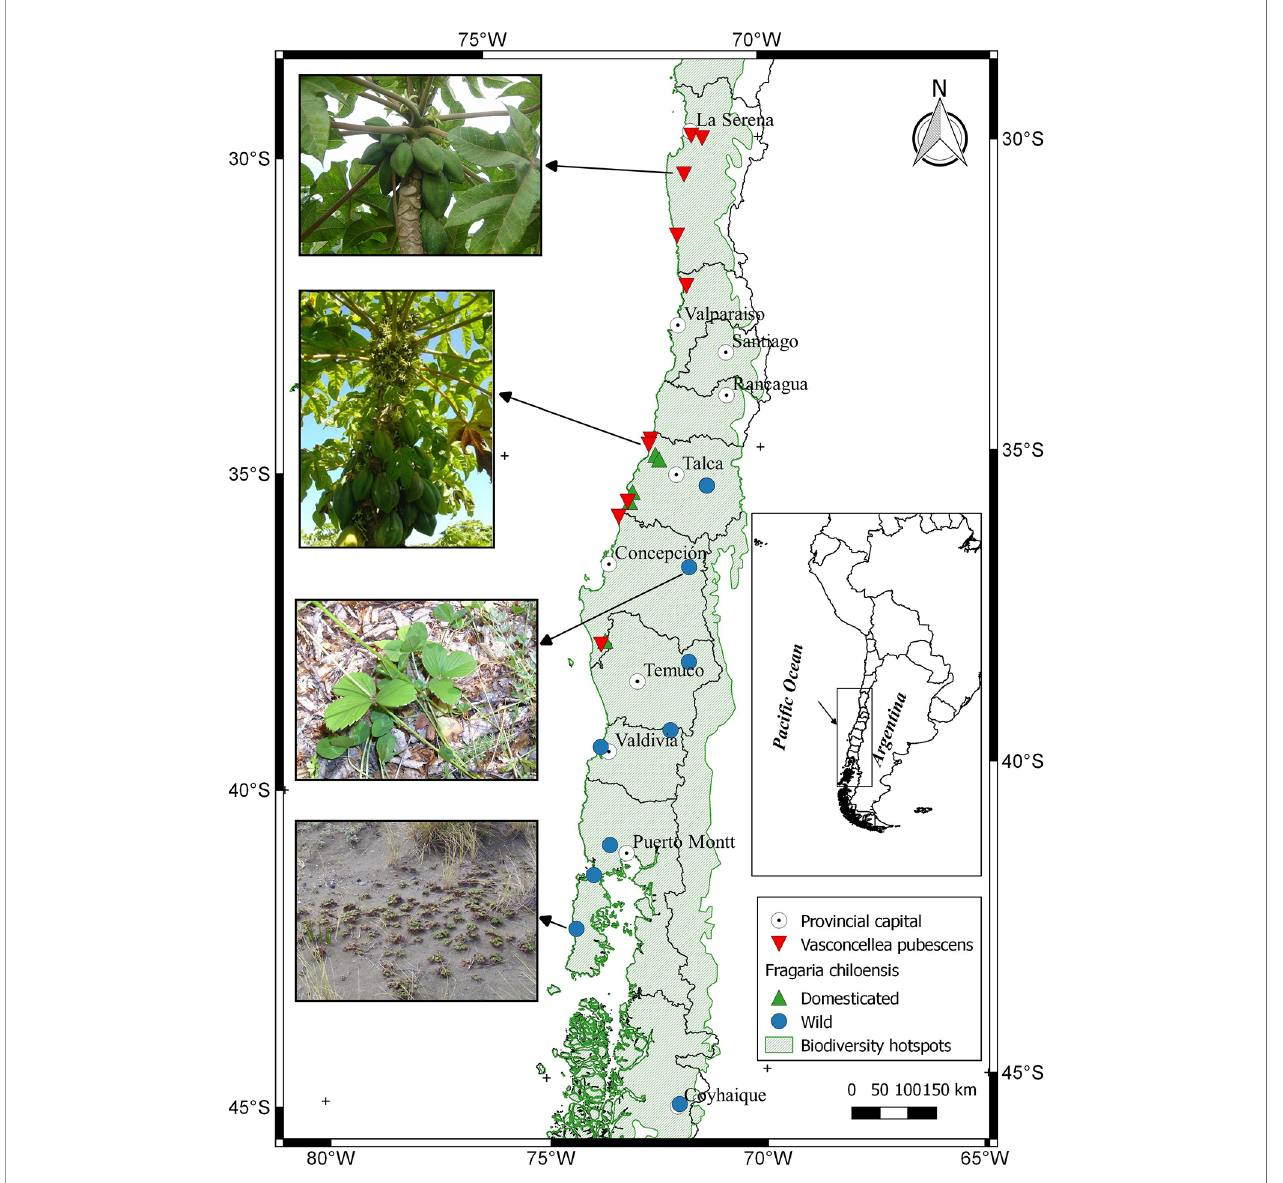
FIGURE 1 | Distribution of Fragaria chiloensis (wild and domesticated) and Vasconcellea pubescens in Chile. The map shows a partial extension (area) of the Chilean Winter Rainfall-Valdivian Forests hotspot. Images located on the left side of the map, from North to South, corresponded to V. pubescens plants grown at the localities of Limar ı ́ and Lipima ́ vida, and for F. chiloensis f. patagonica grown at Termas de Chilla ́ n and Cucao,